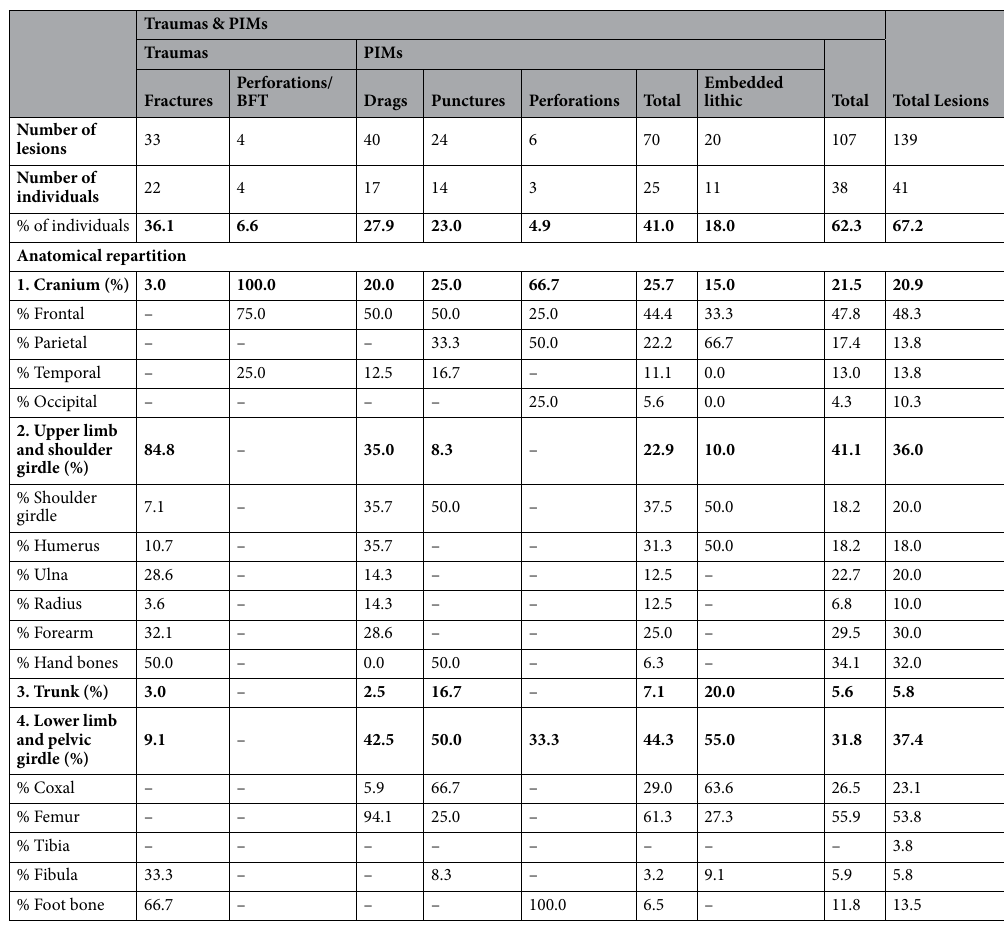
Table 2. Number and type of lesions recorded on the Jebel Sahaba individuals. Percentage of each of these lesions in relation to the anatomical parts in bold numbered lines, and percentage of infliction to specific bones of these anatomical parts in underlying lines. PIM = Projectile Impact Mark; BFT = Blunt Force Trauma; % =